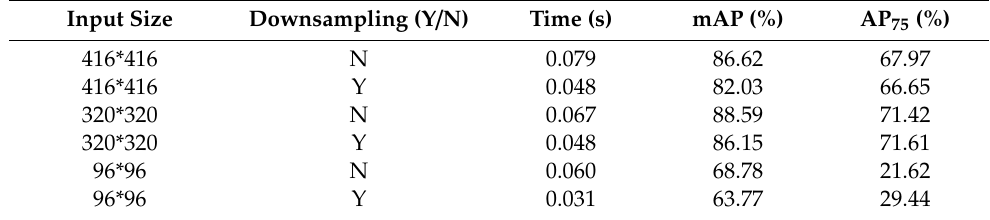
Table 6. Results of the framework with focal loss, with and without downsampling on di ff erent input sizes.